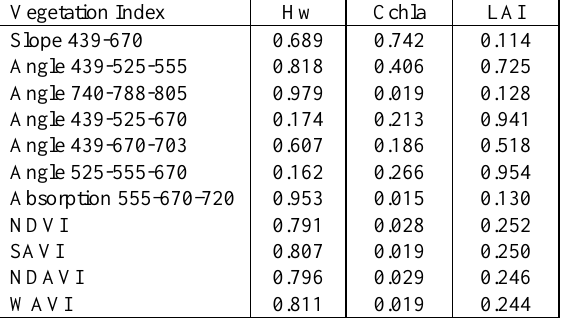
Table 4. The results of global sensitivity analysis